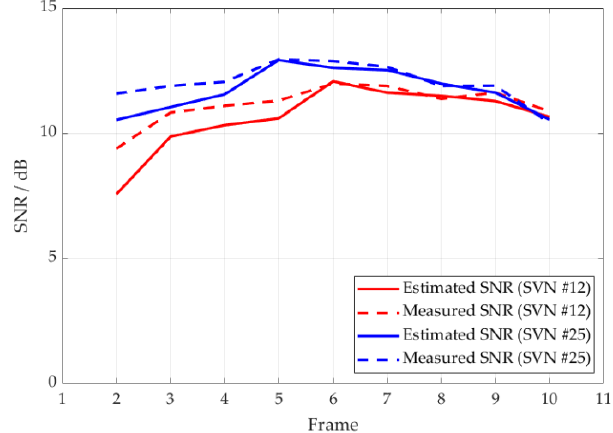
Figure 17. The estimated SNR results using the experiment data.